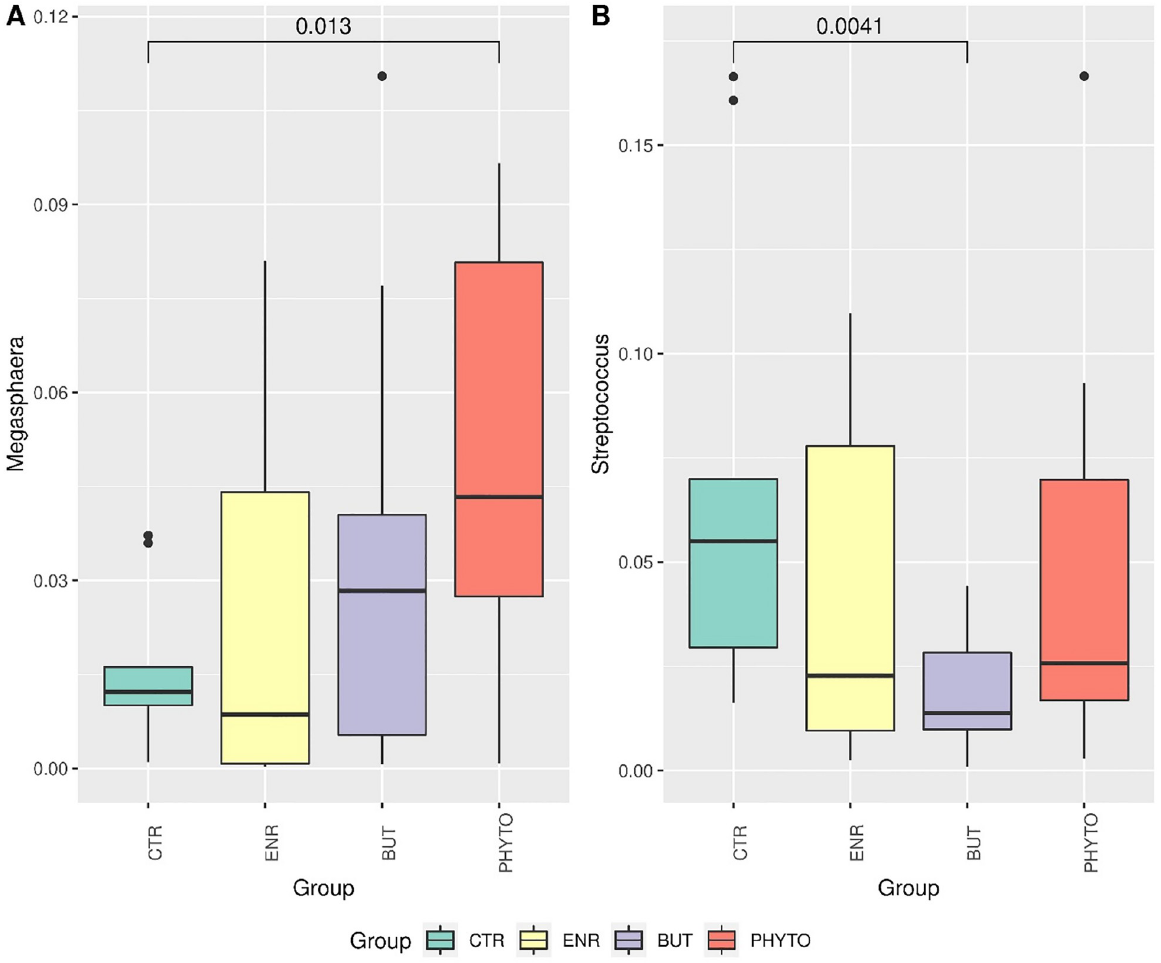
Fig 5. Differential abundance of the genera Megasphaera (A) and Streptococcus (B). Statistical comparison between groups was performed using Wilcoxon’s nonparametric test. Statistical results less than 0.05 were accepted as statistically